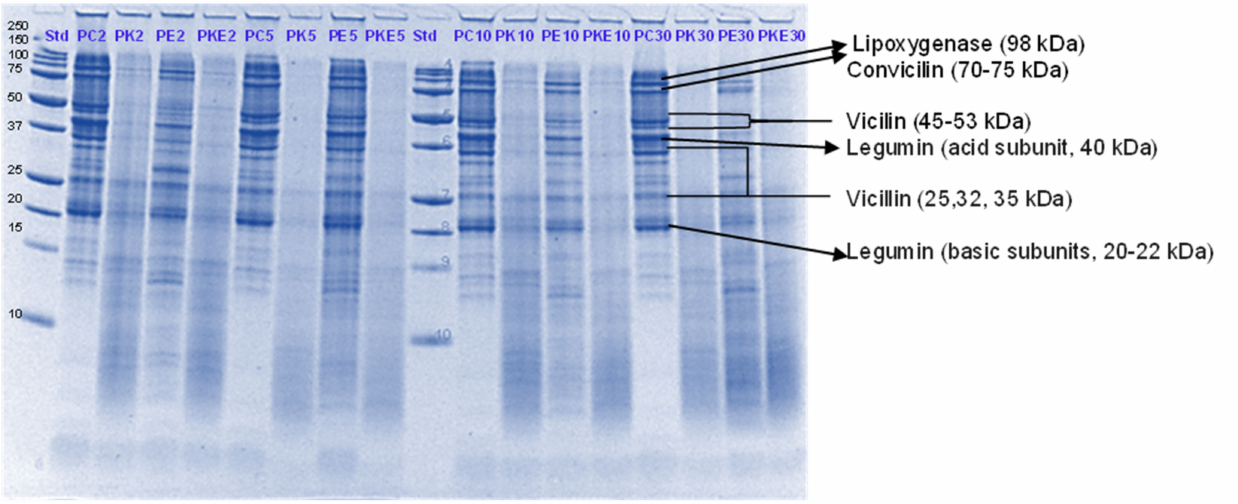
Figure 1. Tricine SDS-PAGE electrophoretogram of pea protein isolate after 2, 5, 10, and 30 min of simulated oral-gastric digestion in the presence or absence of Hayward (K) kiwifruit extract. PC, Pea protein (P) control without any digestive enzymes; PK, with added green kiwifruit extract but no digestive enzymes; PE, with digestive enzymes but no added kiwifruit extract; PKE, with both digestive enzymes and green kiwifruit extract. Numbers 2, 5, 10, and 30 are gastric digestion times following 2 min of oral digestion. Bands (1–10) in the molecular weight standard lane correspond to molecular weights 250, 150, 100, 75, 50, 37, 25, 20, 15 and 10 kDa.